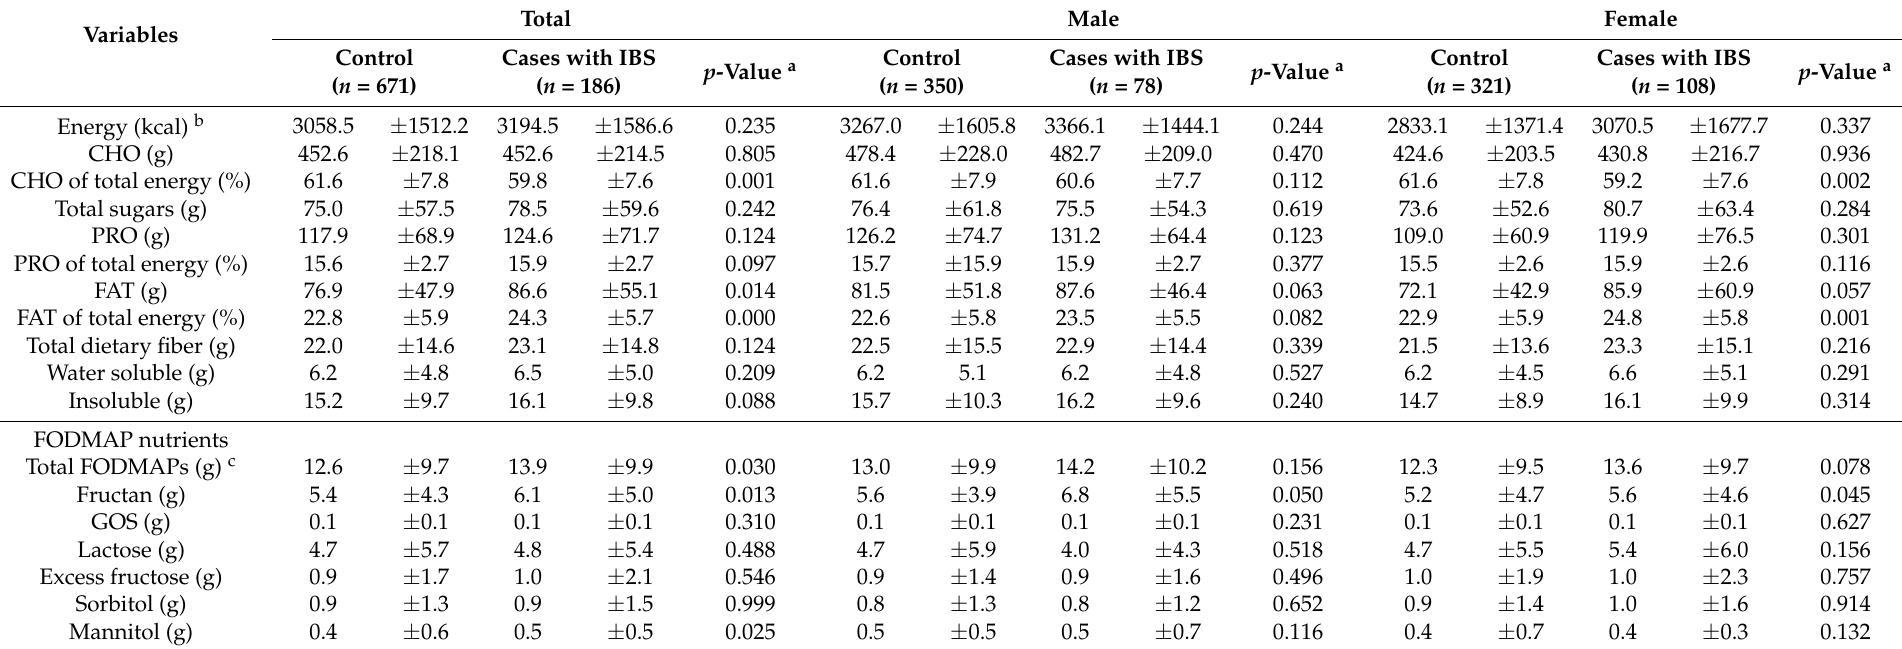
Table 2. Nutrients intake between healthy controls and IBS patients by sex a